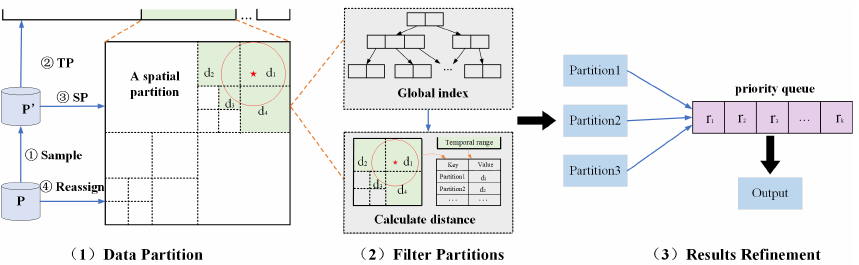
Figure 4. Overview of ST k NNQ